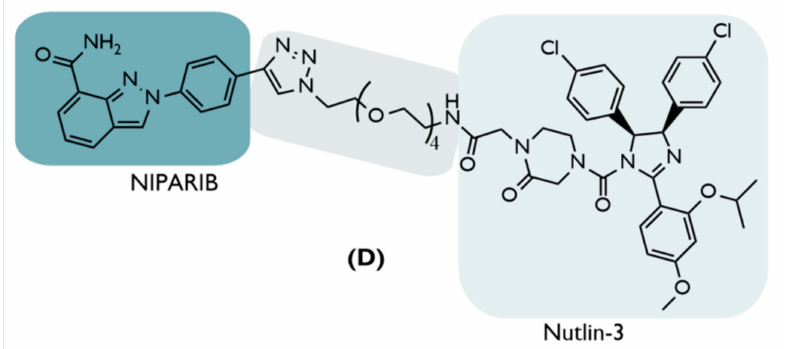
Figure 9. Chemical structure of PROTAC D. Recruiting Poly (ADP-ribose) polymerase-1 (PARP1) through the niparib inhibitor, PROTAC D, degrades the target, recruiting MDM2 via the inhibitor nultin-3. Both inhibitors are linked together through a PEG derivative